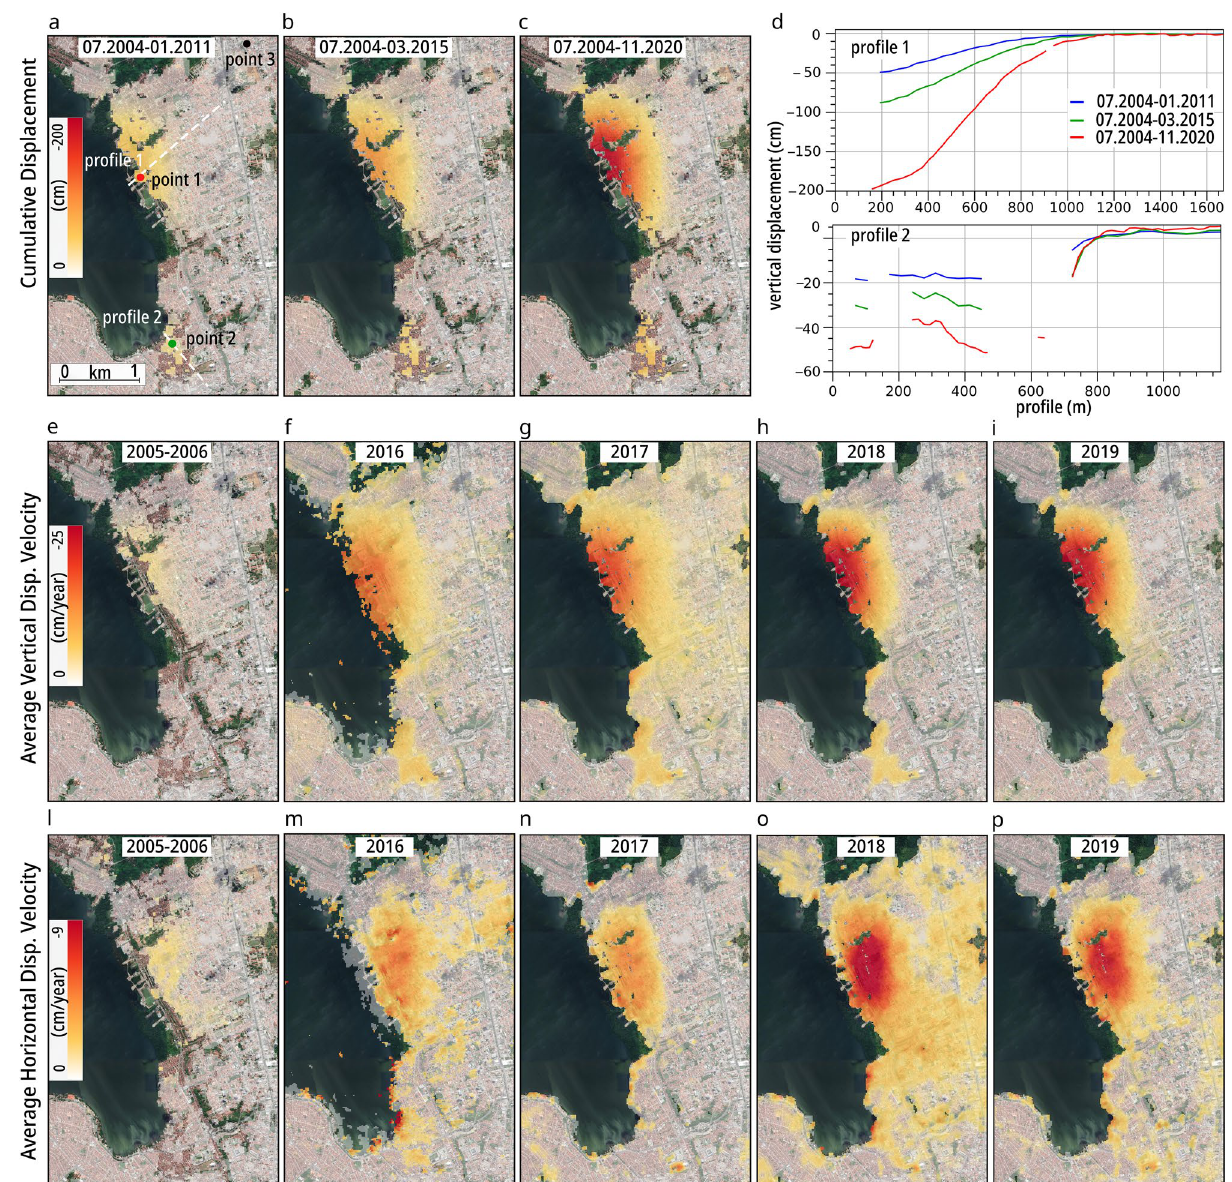
Figure 2. InSAR time series results. ( a–c ) Cumulative vertical subsidence maps obtained by projecting the LOS component into vertical only and combining in time and space all available displacement datasets. Red, green, and black points show the locations of the time series plotted in Fig. 6 respectively point 1 (in the main subsiding area), point 2 (in the minor subsiding area) and point 3 (in hypothetically stable area). White- lines show profile 1 and 2 plotted in ( d ) where the blue line refers to the period 07.2004–01.2011, green for 07.2004–03.2015, and red for 07.2004–11.2020. Ascending and descending displacements have been combined for the periods where both geometries were available to retrieve ( e–i ) vertical and ( l–p ) horizontal average displacement velocities. The horizontal negative values refer to westward motion. Background Google Earth CNES/Airbusimagery. The figures (except d ) were plotted in QGIS (v. 3.16, https:// www. qgis. org/ en/